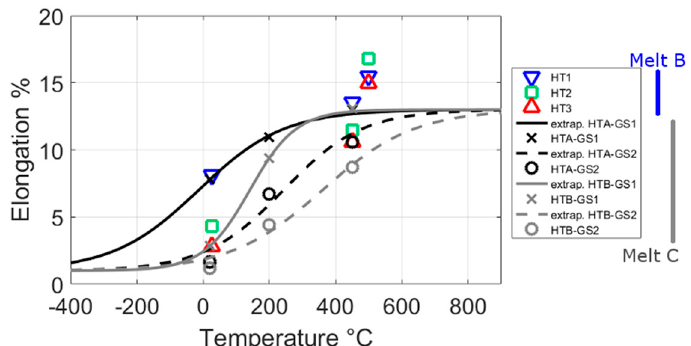
Figure 14. The change in elongation to failure of Melt B and Melt C, which are the same alloy as that in this paper but with slightly different processing. The three heat-treatments of Melt B have different austenitisation temperatures of 825 °C (HT1), 875 °C (HT2) and 960 °C (HT3). For more details on the melts see the start of the discussion or [8,19].